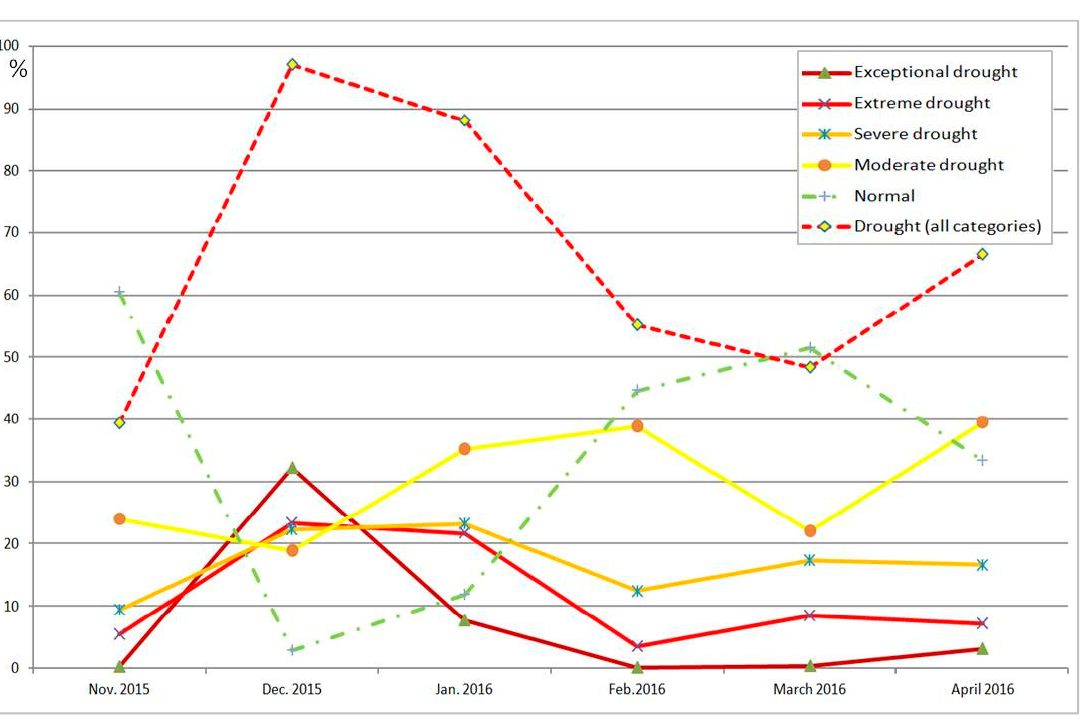
Figure 8. Evolution of CDI classes (in %) during 2015–2016 growing season.